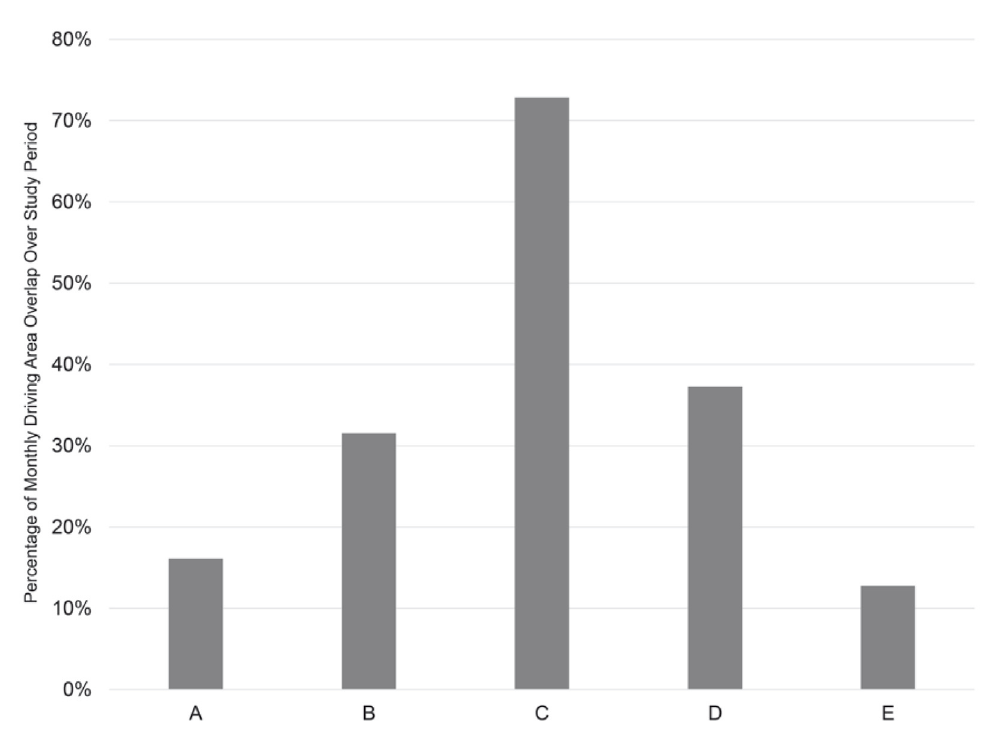
Figure 7. Ratio of overlapping driving area to total driving area over the 5 month